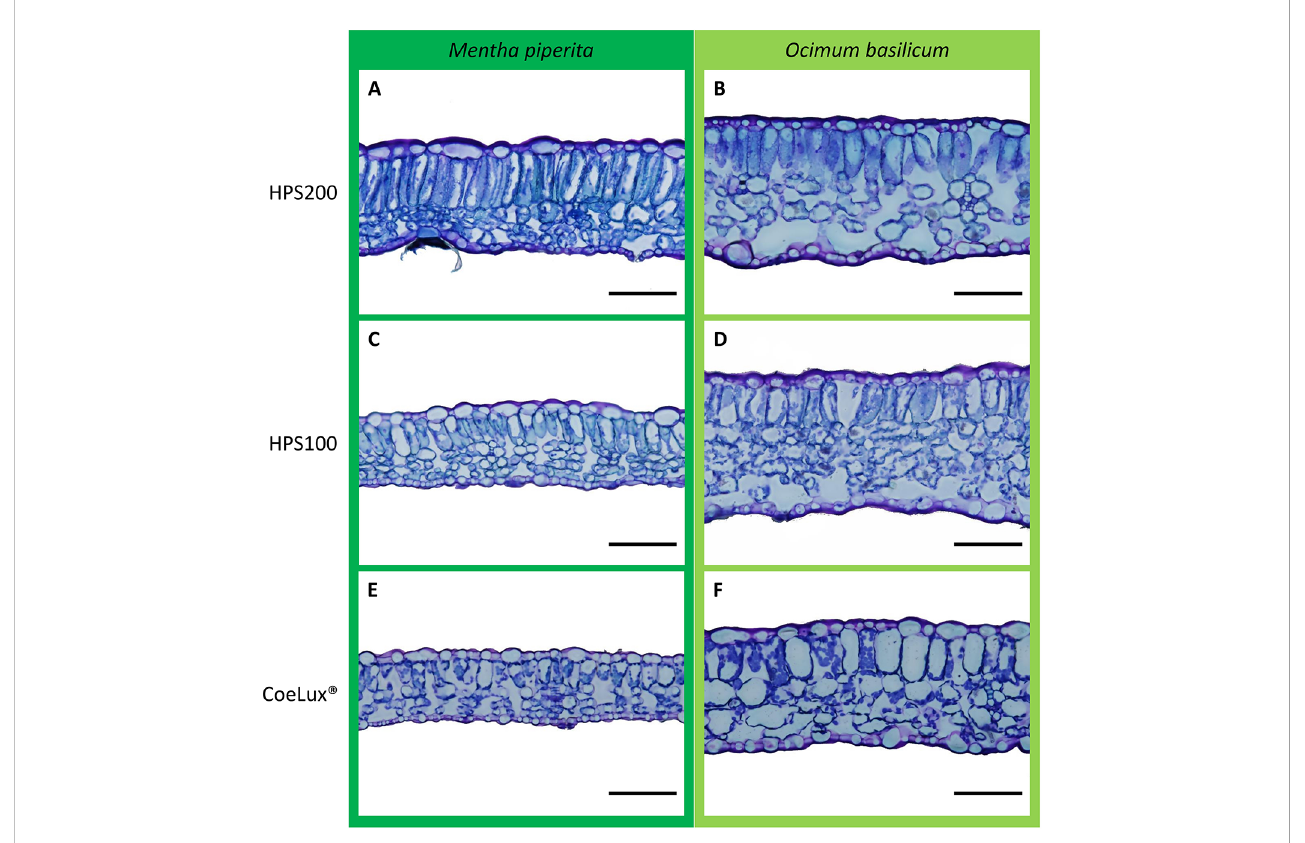
FIGURE 3 Comparison of representative leaves sections of Mentha piperita (dark green) and Ocimum basilicum (light green) grown under different light treatments, respectively (A, B) HPS200, (C, D) HPS100, and (E, F) CoeLux ® . Images were obtained by optical microscopy using 10 µm slices of the central part of the fully expanded younger leaf. The black bar represents a 100 µm reference.